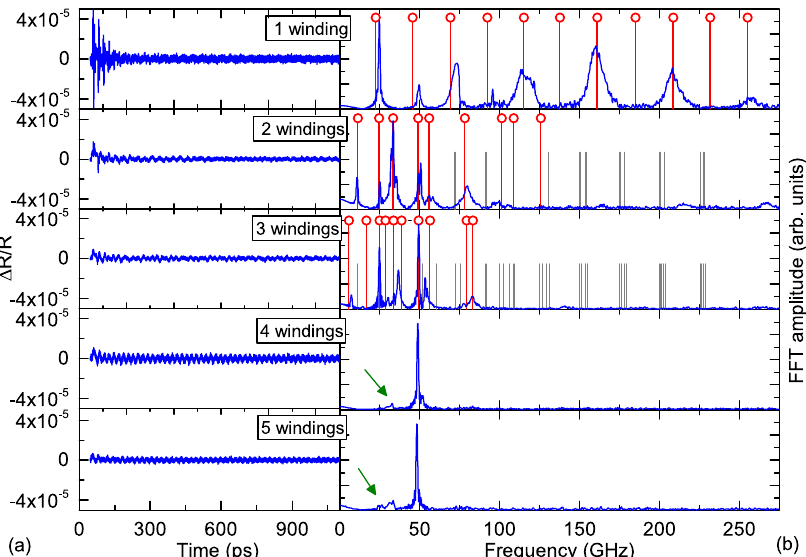
Figure 5. ( a ) The extracted oscillations of the reflectivity change of different parts of the tube (of sample B r ) with a number of windings from 1 to 5 (from top to bottom) are presented. ( b ) The corresponding FFTs. The transition from the frequencies of a single oscillating bilayer towards modes of a multilayer is visible. In the FFT additionally to the experimental results also the calculations of the modes (vertical lines) based on a transfer matrix method with a massless spring in between the layers are presented. The green arrows mark the remaining acoustic contributions for the 4 and 5 windings sample for better